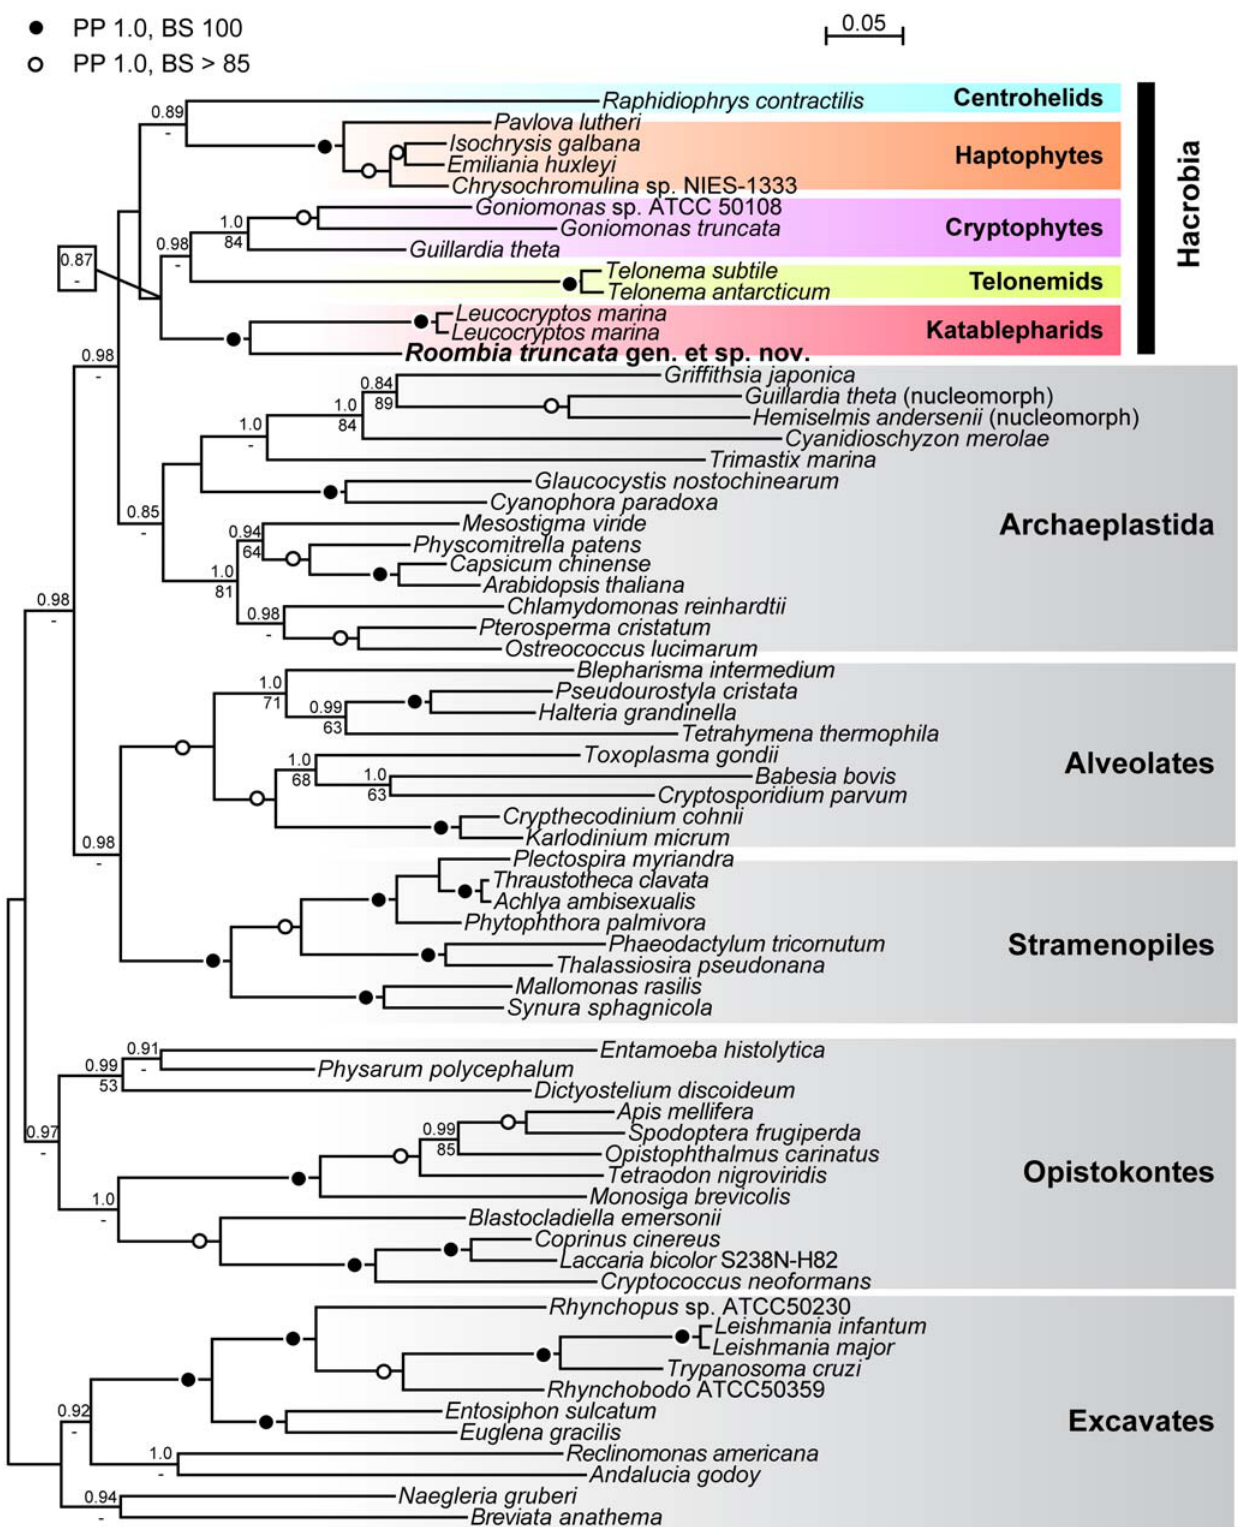
Figure 5. Molecular phylogeny based on Hsp90. The maximum likelihood (ML) topology based on Hsp90 sequences constructed using RTREV + GAMMA + F model of evolution. Black circles denote the branches supported by posterior probability (PP) of 1.0 and bootstrap support (BS) of 100. Opencircles denotethebranches supportedby PPof 1.0and BShigher than90.BSwas inferredfrom1000replicationsusingRAxML7.0.4, PPwereassessed from 10 6 generations with MrBayes 3.1.2 (see Methods part for details). Supergroups are boxed and shaded different colours, numbers at nodes.